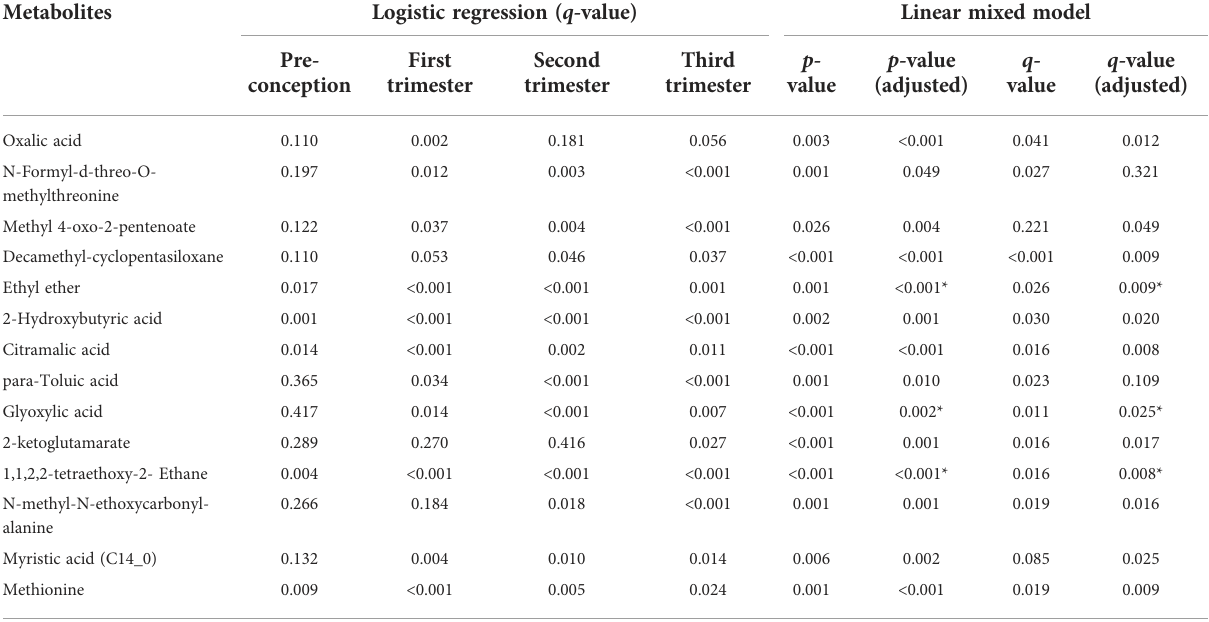
TABLE 2 Metabolites with signi fi cant and robust differences between GDM cases and non-GDM controls in logistic regression and linear mixed models. Metabolites Logistic regression ( q